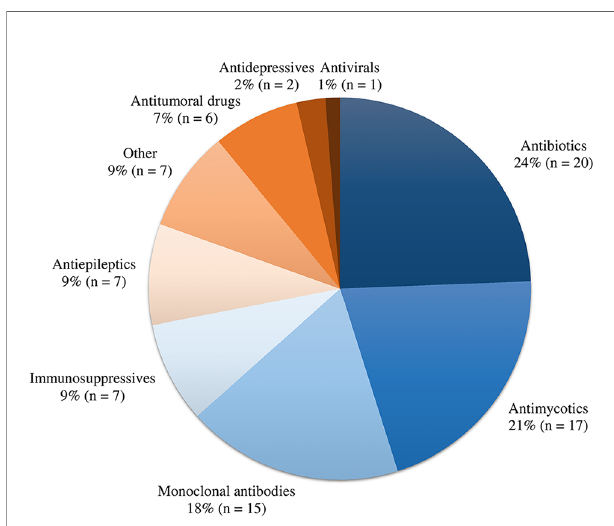
FIGURE 2 | Overview of drug classes involved in precision dosing programs of the participating